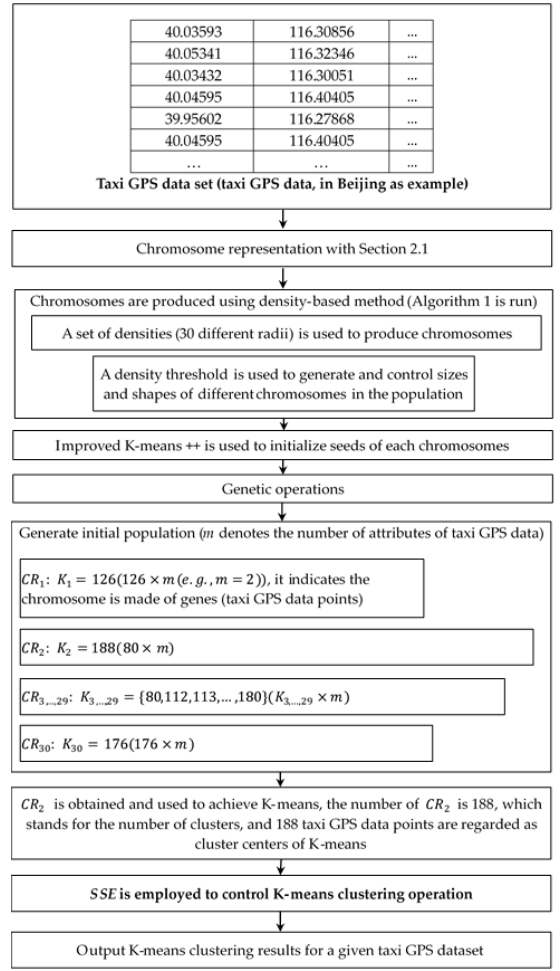
Figure 1. Diagram of SeedClust using the density-based and improved K-means++.